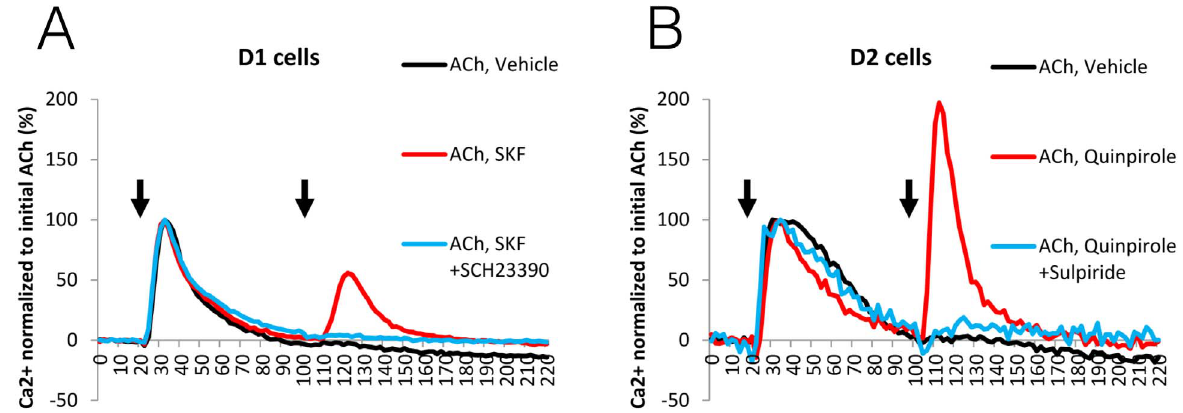
Figure 7. Potentiation of G a q -mediated calcium flux is induced specifically by activation of D1-like and D2-like dopamine receptors. Intracellular calcium levels were measured every 2 seconds and plotted against time. Ca 2 + level is shown in percentage normalized to the initial 10 5 M acetylcholine (ACh) added at 20 secs. (A) In D1 stable cells, either vehicle control (black curve), 10 5 M SKF81297 (D1 agonist, red curve), or 10 5 M SKF81297 with 10 5 M SCH23390 (D1 antagonist, blue curve) was added at 100 secs following 10 5 M ACh at 20 secs, indicated by arrows. (B) In D2 stable cells, either vehicle control (black curve), 10 5 M Quinpirole (D2 agonist, red curve), or 10 5 M Quinpirole with 10 5 M Sulpiride (D2 antagonist, blue curve) was added at 100 secs following 10 5 M ACh at 20 secs, indicated by arrows. Traces are representatives of n=3